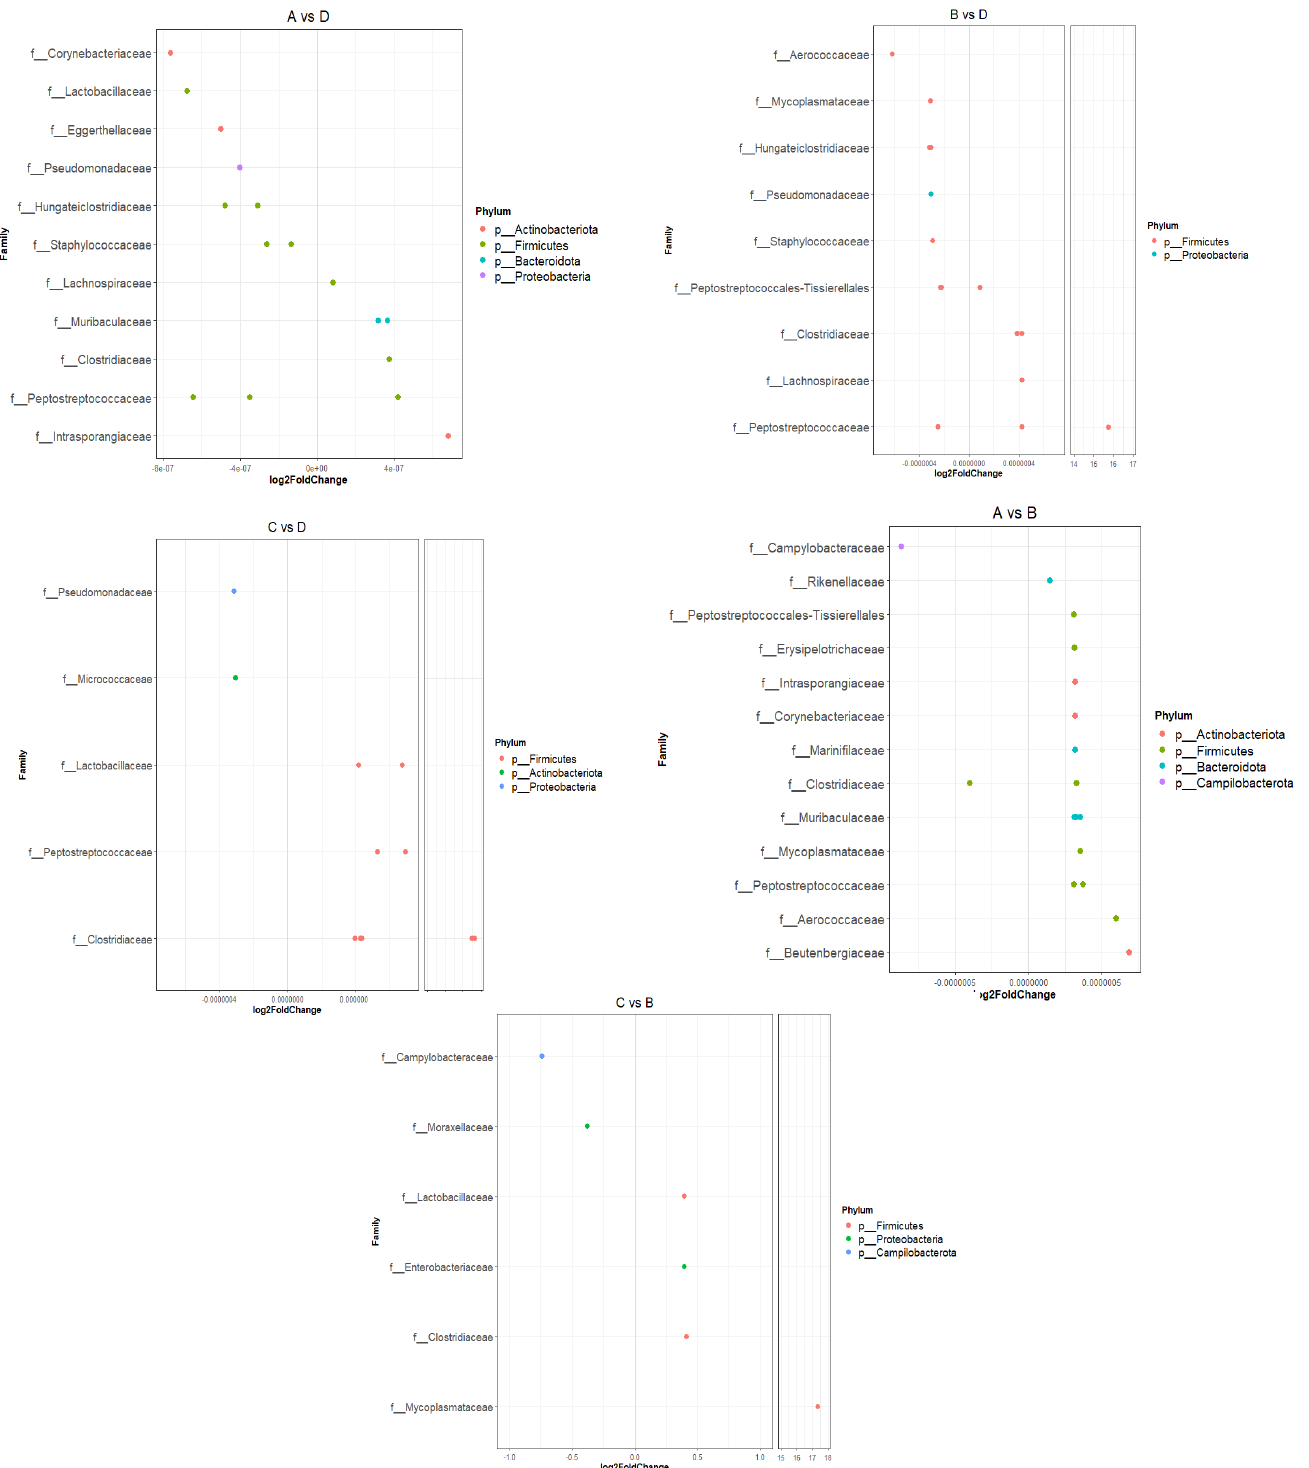
Figure 11. Differentially abundant ASVs depicting the log2fold differential abundance of the different families for pairwise comparisons among groups (DESeq2 analysis). Differences were considered significant with an adjusted p -value of 0.01. Log2fold values greater than zero indicate an increase (enrichment) in the relevant ASVs of the test group (A, B or C), whereas negative values indicate higher abundances in the control group